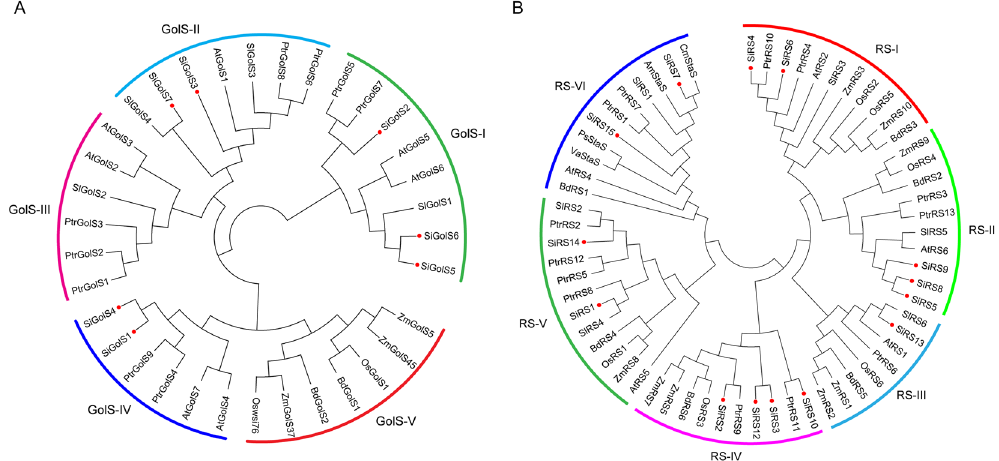
Figure 2. Phylogenetic analysis of GolSs and RSs from sesame and other species. ( A ) The deduced full- length amino acid sequences of 7 SiGolSs and 27 GolSs from 6 representative sequenced plant species (see Supplementary Table S2) were used for phylogenetic tree construction. ( B ) The deduced full-length amino acid sequences of 14 SiRSs, 44 RSs from six representative sequenced plant species (see Supplementary Table S3) and 4 referenece StaSs from Vigna angularis (VaStaS, CAB64363), Pisum sativum (PsStaS, CAC38094), Cucumis melo (CmStaS, XP_008451468) and Alonsoa meridionalis (AmStaS, CAD31704) were used for phylogenetic